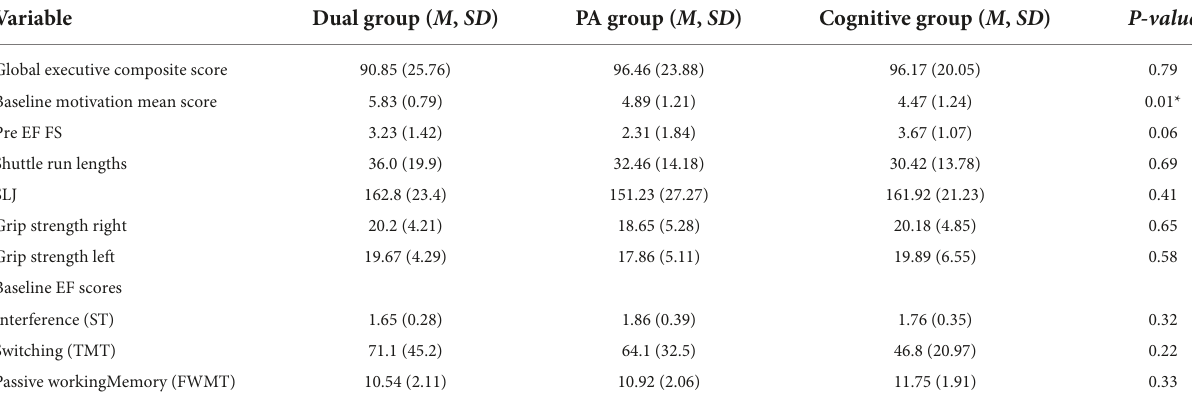
TABLE 2 Pre-manipulation characteristics of the study sample.